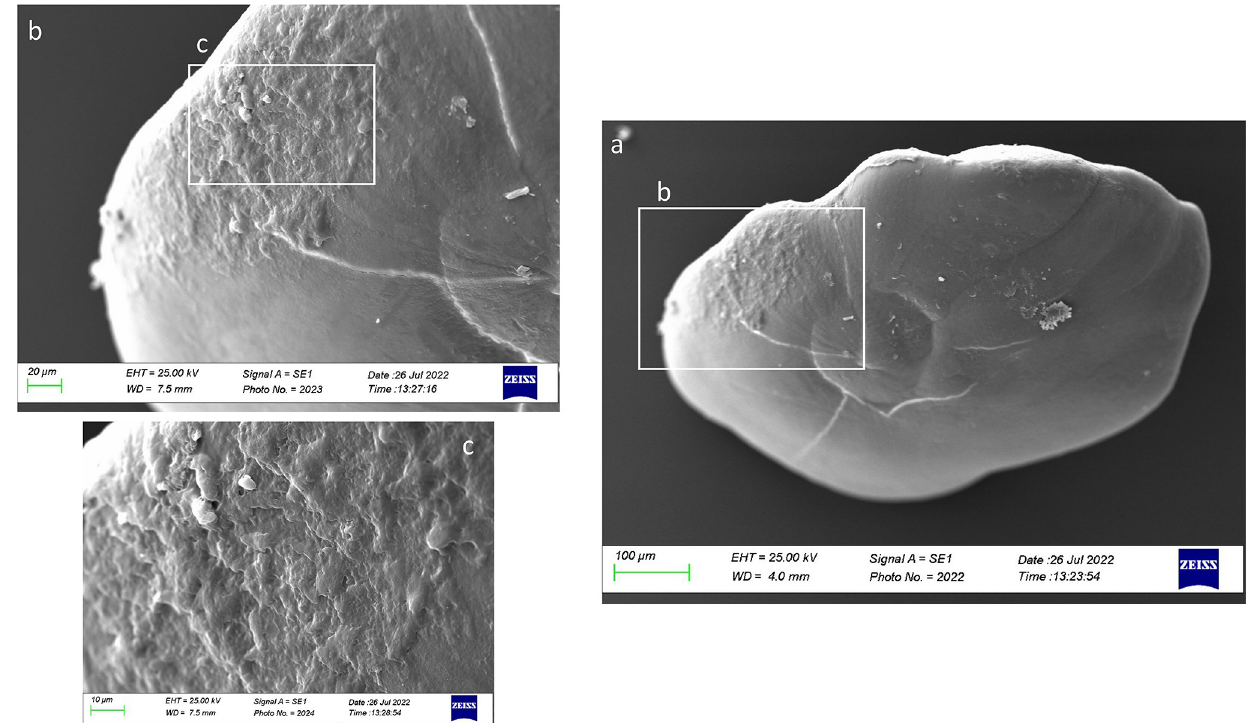
Fig 14. SEM images of a right sagitta external surface belonging to size Class III (a) with detail of the external textural organization near the excisura ostii (b, c).